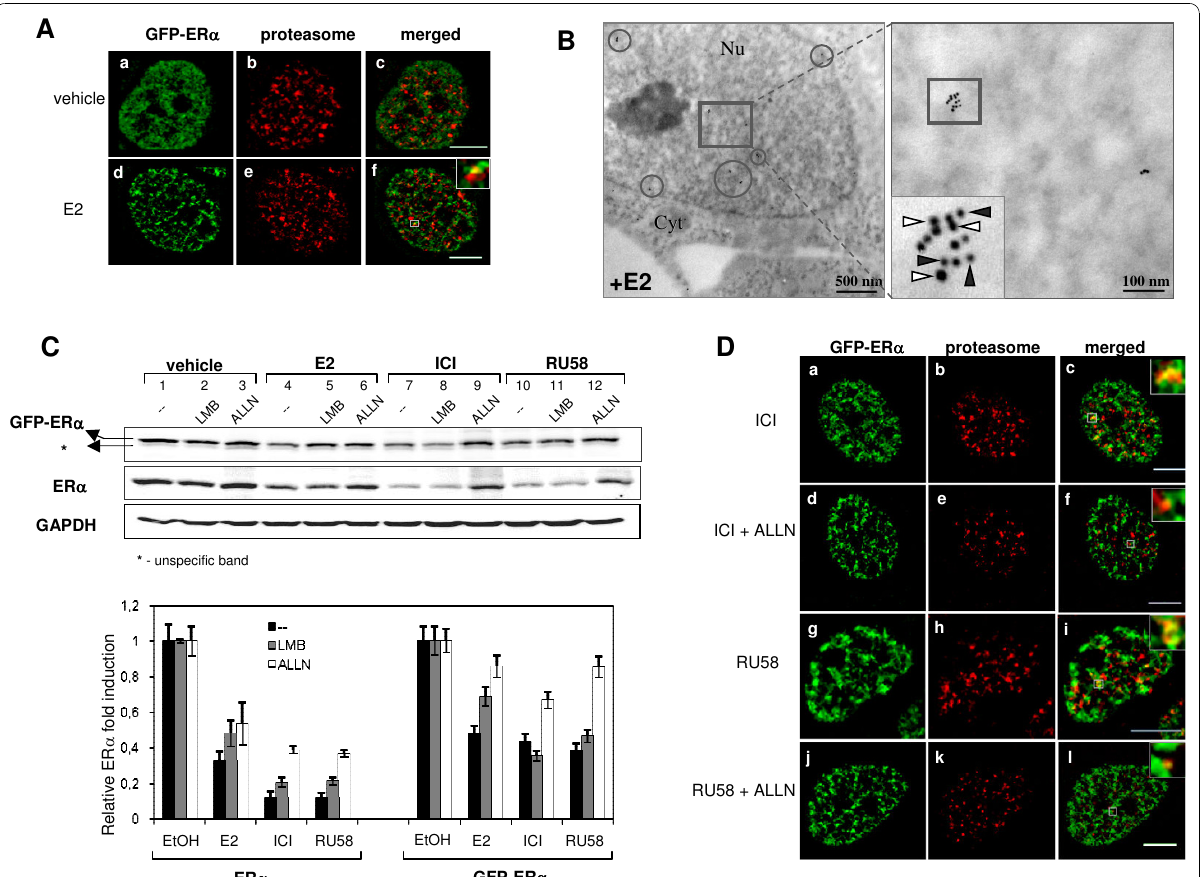
Figure 4 Nuclear Proteasome-GFP-ER a contacts are frequent in the presence of E2 and SERDs . A) SK19 cells treated for 3 h with drugs as described in Methods. Cells were fixed and subjected to immunofluorescence using a monoclonal anti-20S proteasome subunit a 2 primary antibody, followed by incubation with the Alexa Fluor® 647 goat anti-mouse secondary antibody. Right panels represent colocalization of GFP-ER a and 20S proteasome ( insets ): untreated cells (4A, c ) and 10nM E2 treated cells (4A, f ),. Images are representative of three independent experiments. Bar, 5 μ m. B) 80 nm thin sections of MCF-7 cells were incubated with anti-ER a and anti-20S proteasome subunit a 2 antibodies. Secondary antibodies coupled with 10 nm and 6 nm gold particles were used against anti-ER a (white arrowhead) and anti-20S proteasome (black arrowhead), respectively. Grids were then processed for electron microscopy. Colocalization of both proteins is indicated by circles. Bar, 500 nm. The area of selected electron micrograph shows colocalization clusters where at least 3 gold particles for each protein are present (inset). Bar, 100 nm. C) Western blot showing SERD-mediated degradation of ER a through the nuclear proteasome. SK19 cells were pre-treated or not with inhibitor of nuclear export (10 nM LMB) or proteasome inhibitor (100 μ M ALLN) for 30 min and then treated with vehicle (EtOH as reference), 10 nM E2, 1 μ M ICI, or 1 μ M RU58 for 3 h. ER a and GAPDH (internal control) detection by Western blotting shows proteasome-dependent degradation of ER a upon E2 and SERDs stimulation. D) SK19 cells treated for 3 h with SERDs were pre-treated or not with proteasome inhibitor ALLN (details see in Methods). Right panels represent colocalization of GFP-EP a and 20S proteasome subunit a 2 ( insets ): SERDs pre-treated cells without (4D c and i ) or with (4D f and l ) 100 μ M ALLN. Images are representative of three independent experiments. Bar, 5 μ